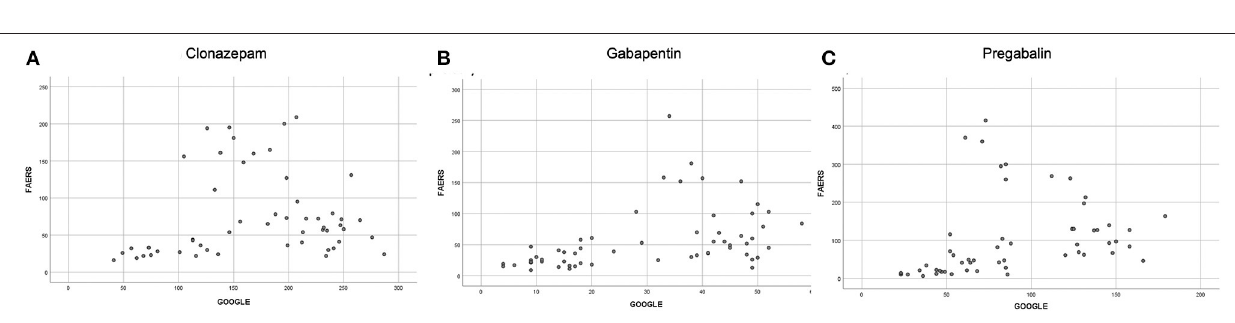
FIGURE 4 | Correlation between FAERS and Google searches for (A) clonazepam ( r = 0.295; p = 0.030); (B) gabapentin ( r = 0.558; p < 0.001); (C) pregabalin ( r = 0.587; p <